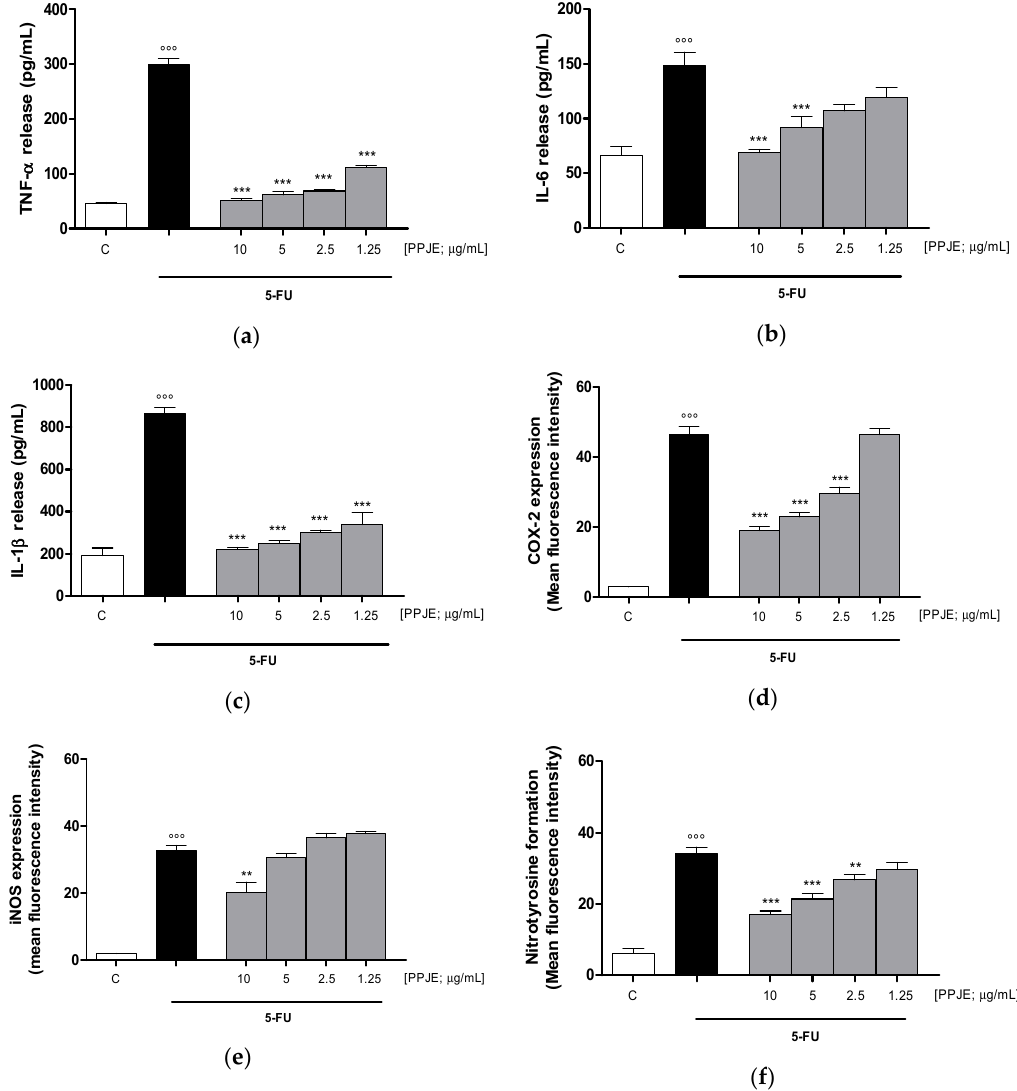
Figure 5. Effect of PPJE (10–1.25 μ g/mL) on proinflammatory mediators’ inhibition in 5FU-treated IEC-6. TNF- α ( a ), IL-6 ( b ) and IL-1 β ( c )were detected by ELISA assay. Effect of PPJE (10–1.25 μ g/mL) on COX-2 ( d ) and iNOS ( e ) expression, and nitrotyrosine formation ( f ), detected by flow cytometry. Data are expressed as pg/mL of cytokines release or as mean fluorescence intensity. *** and ** denote respectively p < 0.001 and p < 0.01 vs . 5-FU; °°° denotes p < 0.001 vs . C.